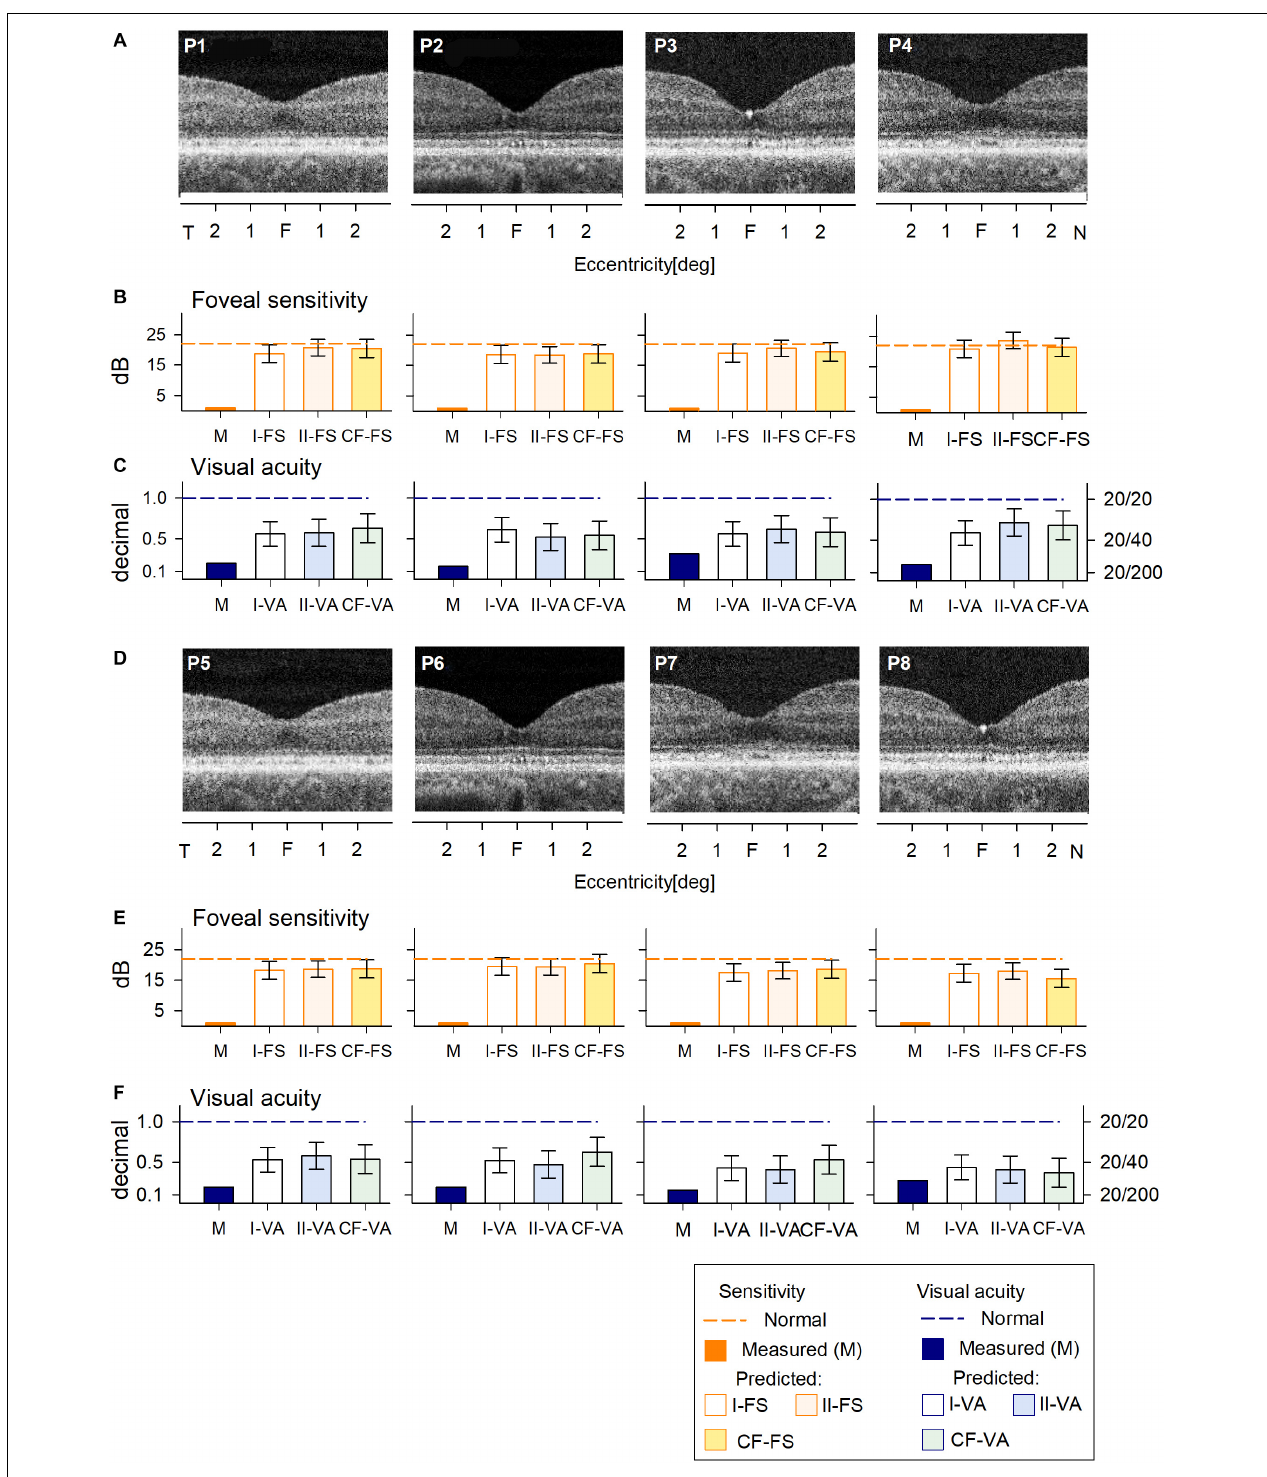
FIGURE 3 | Prediction of FS and VA of BCM patients with large deletion mutations. (A) Foveal region OCT scans from four BCM patients (ages 7–13 years). (B) Non-detectable sensitivity at foveal location (orange bar) and predicted results by Model I-FS (white bar) and Model II-FS (light orange bar) as in Figure 1 . Yellow bar is sensitivity value calculated by formula extracted from curve fitting (CF-FS). (C) Comparison of measured VA (dark blue bar) and predicted results by Model I-VA (white bar) and Model II-VA (light blue bar). Light green bar is visual acuity calculated by formula extracted from curve fitting (CF-VA). (D–F) are the same as (A–C) but BCM patients are older (ages 18–35 years); dashed lines in (B,C,E,F) represent lower boundary of normal range. Error bars represent RSME for corresponding model.